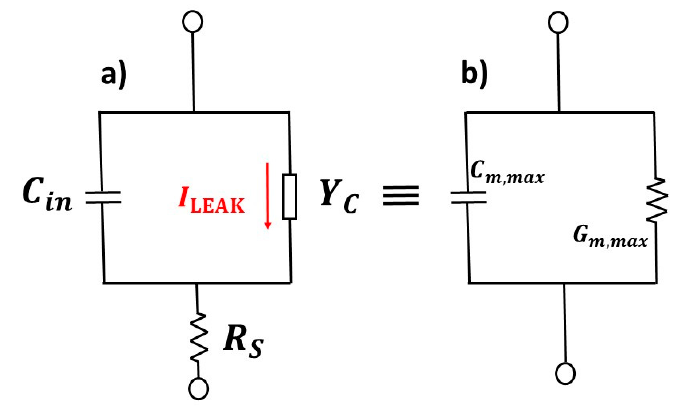
Figure 11. ( a ) Simplified electrical Rajab model. With Y C being the admittance, which represents the leakage process, and R S is the series resistance associated with the silicon substrate; and ( b ) measured G m,max and C m,max , which are the accumulation conductance and capacitance, respectively.